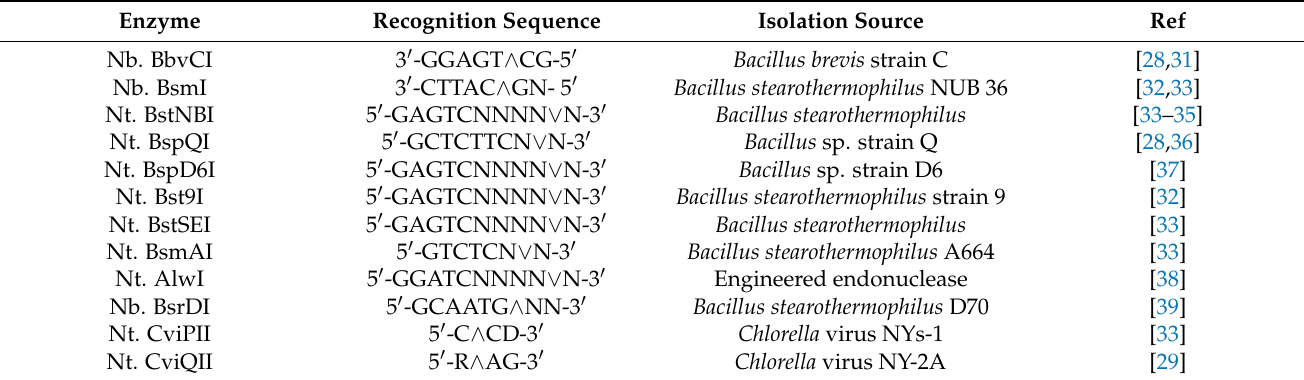
Table 1. Characteristics of important nicking